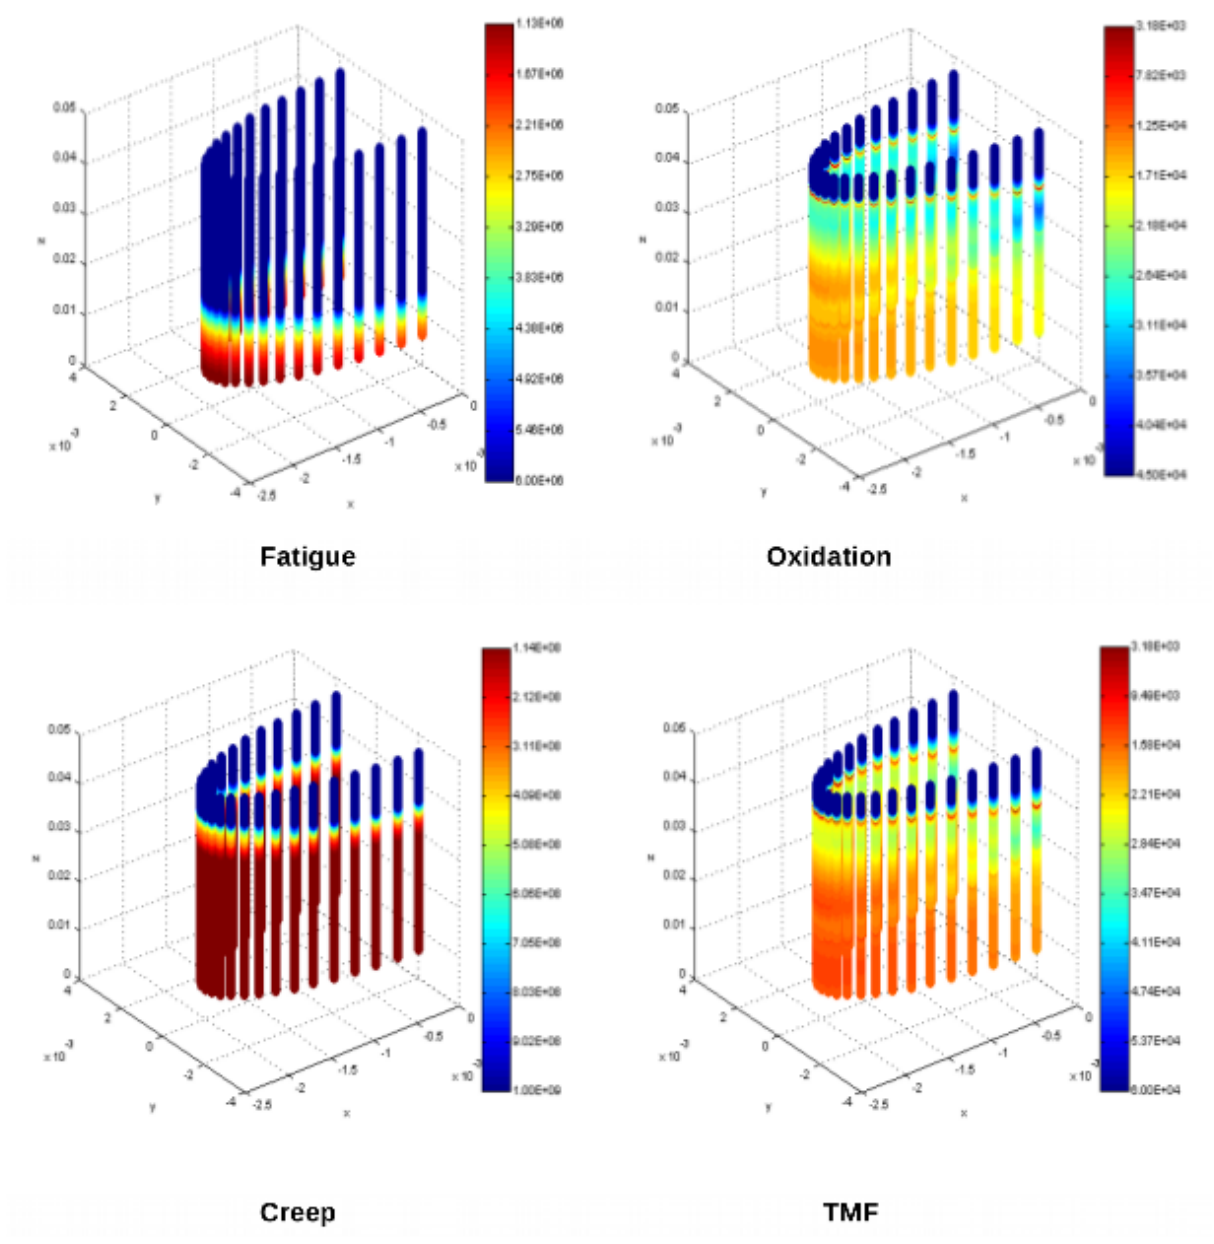
Figure 8: Life distribution for damage